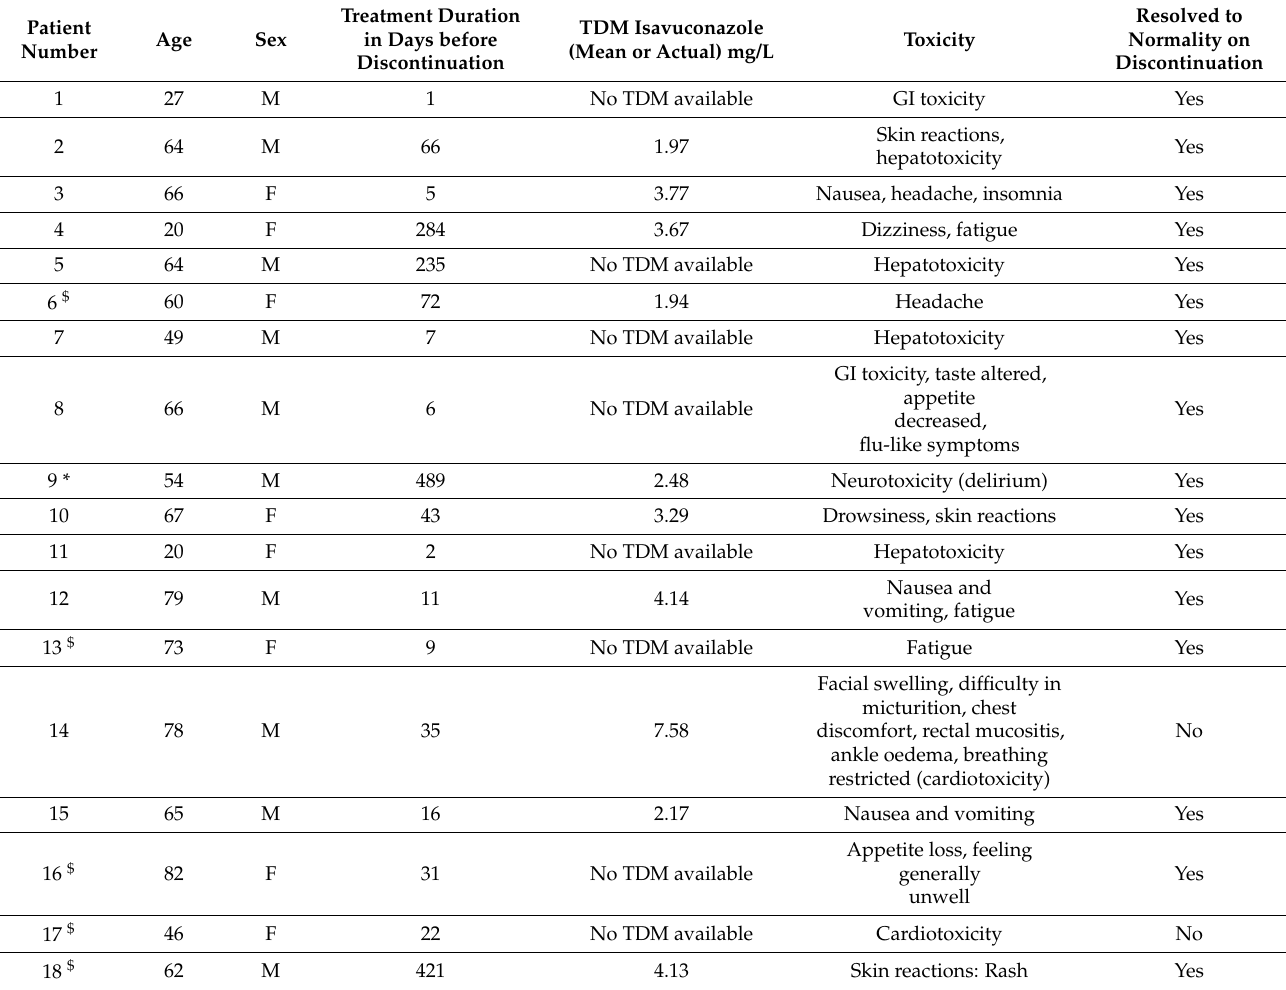
Table 2. Table of adverse effects experienced by patients in this study.